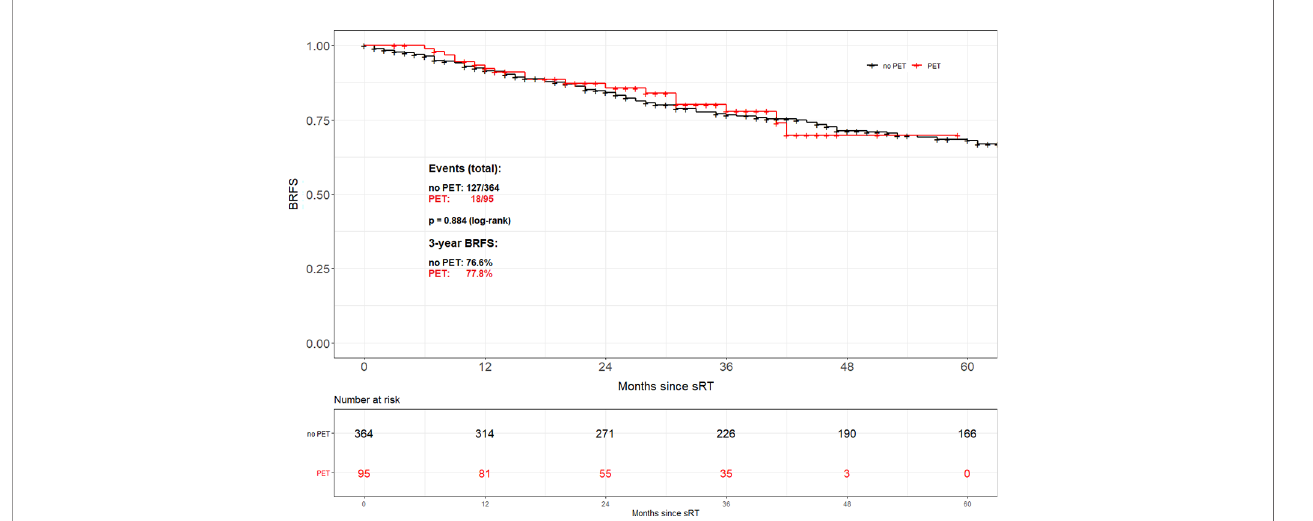
FIGURE 1 | Biochemical recurrence-free survival according to the use of PSMA PET/CT for the entire cohort.